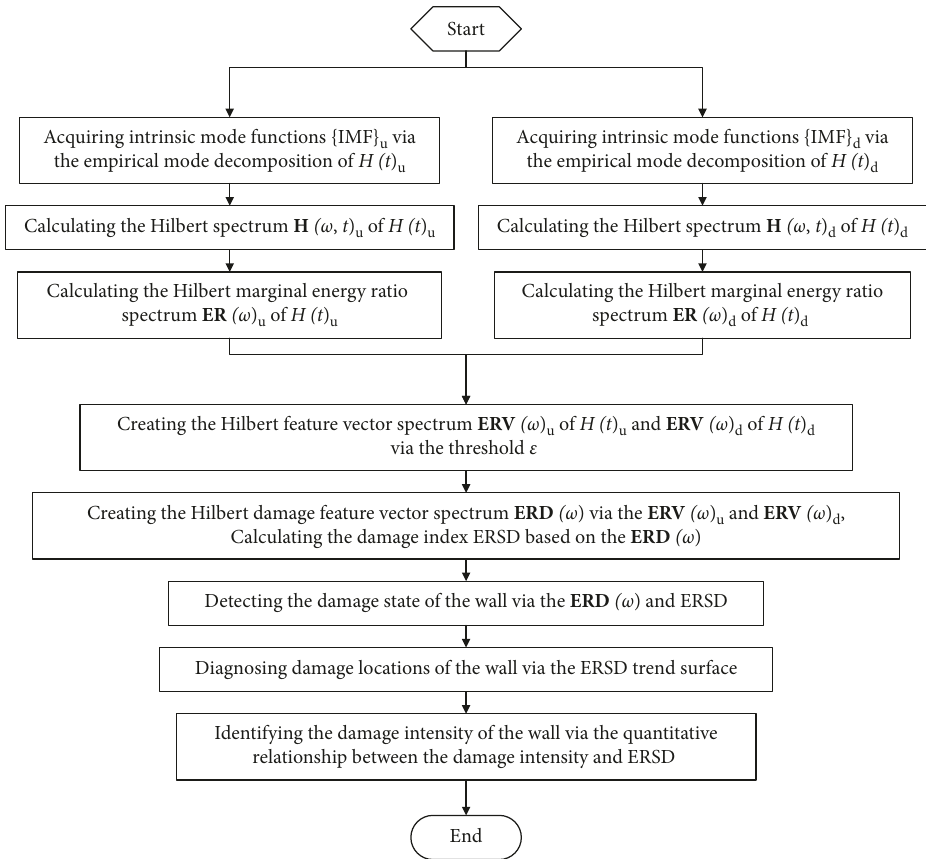
Figure 2: Flowchart of damage diagnosis for retaining wall structures.